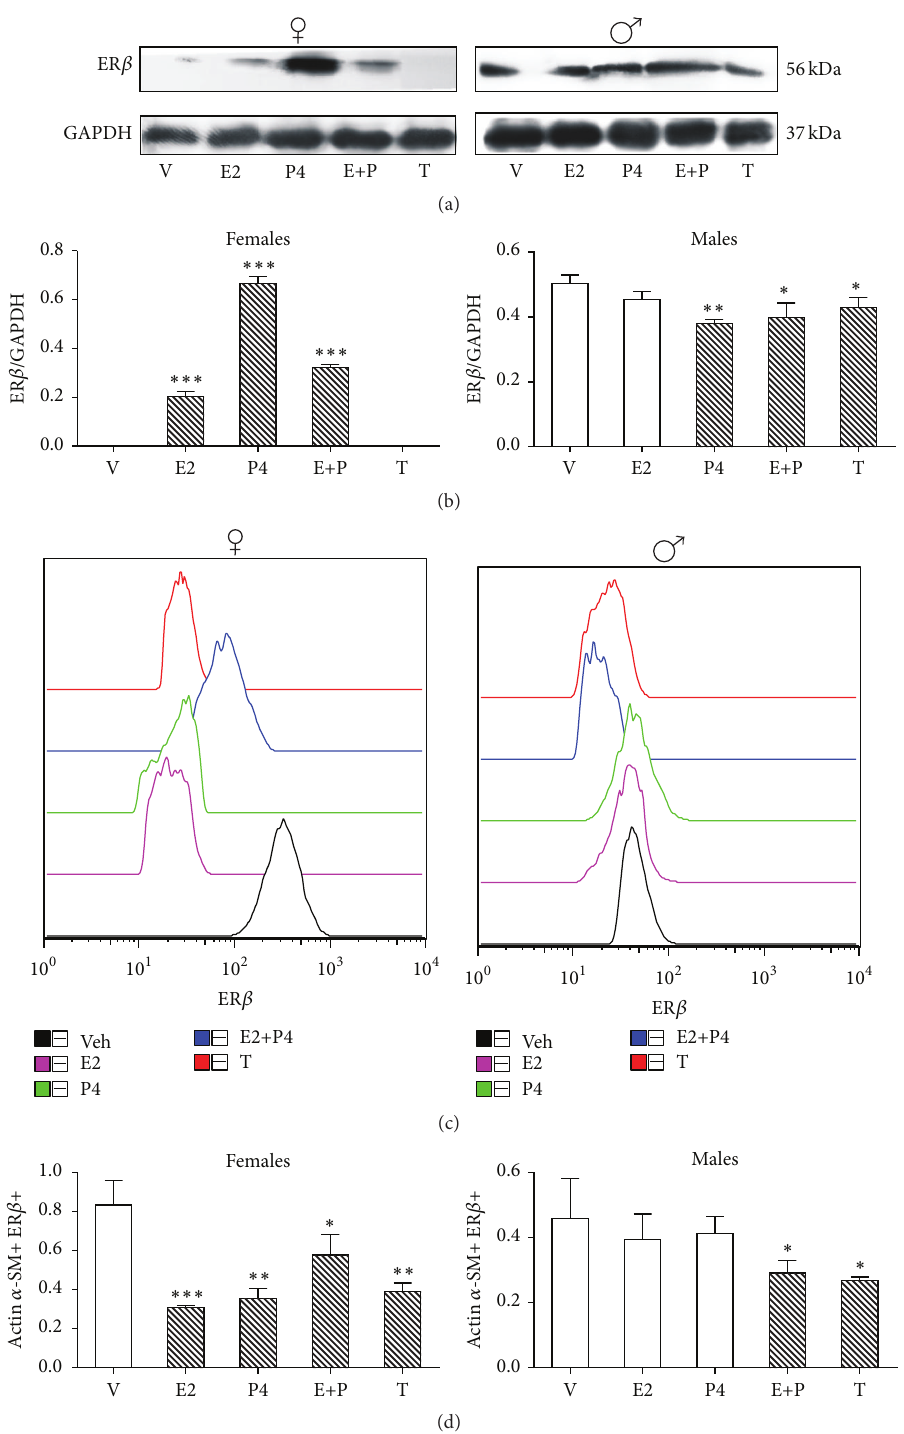
Figure 2: Regulation of ER 𝛽 protein content by sex hormones in airway smooth muscle (ASM) and airway smooth muscle cells (ASMC). ER 𝛽 protein content in ASM and ASMC of gonadectomized female and male rats were treated as described in Figure 1 legend. (a) A representative assayoffourWesternblotexperimentsisshown(detailsaredescribedinFigure1legend).(b)ProteinsdetectedbyWesternblotwerequantified by densitometric analysis and corrected by GAPDH protein content. Results are expressed as mean ± SD, 𝑛 = 4 . ∗ 𝑝 < 0.05 compared with vehicle treatment, ∗∗ 𝑝 < 0.01 compared with vehicle treatment, and ∗∗∗ 𝑝 < 0.001 compared with vehicle treatment. (c) Flow cytometry histogram plots are based on forward scatter (FSC) and side scatter (SSC) gating for ASMC. This was validated using actin 𝛼 -smooth muscle and ER 𝛽 staining. A representative example of the gating strategy is shown. (d) Geometric mean fluorescence intensity (gMFI) for ER 𝛽 expression on ASMC. Results are expressed as mean ± SD, 𝑛 = 4 . ∗ 𝑝 < 0.05 compared with vehicle treatment.